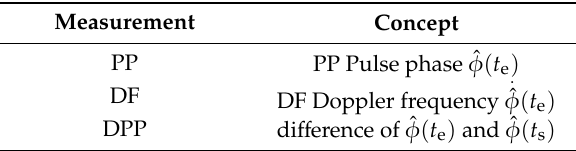
Table 3. Concepts of di ff erent